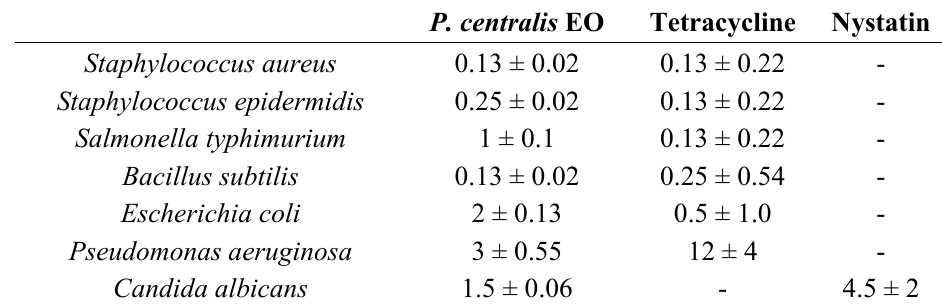
Table 2. Minimum Inhibitory Concentration (MIC) (Mean ± Standard Error of the Mean (SEM)) of Prostanthera centralis essential oil ( P. centralis EO) against microorganisms in % v/v agar with positive controls in μ g/mL ± SEM (Tetracycline and